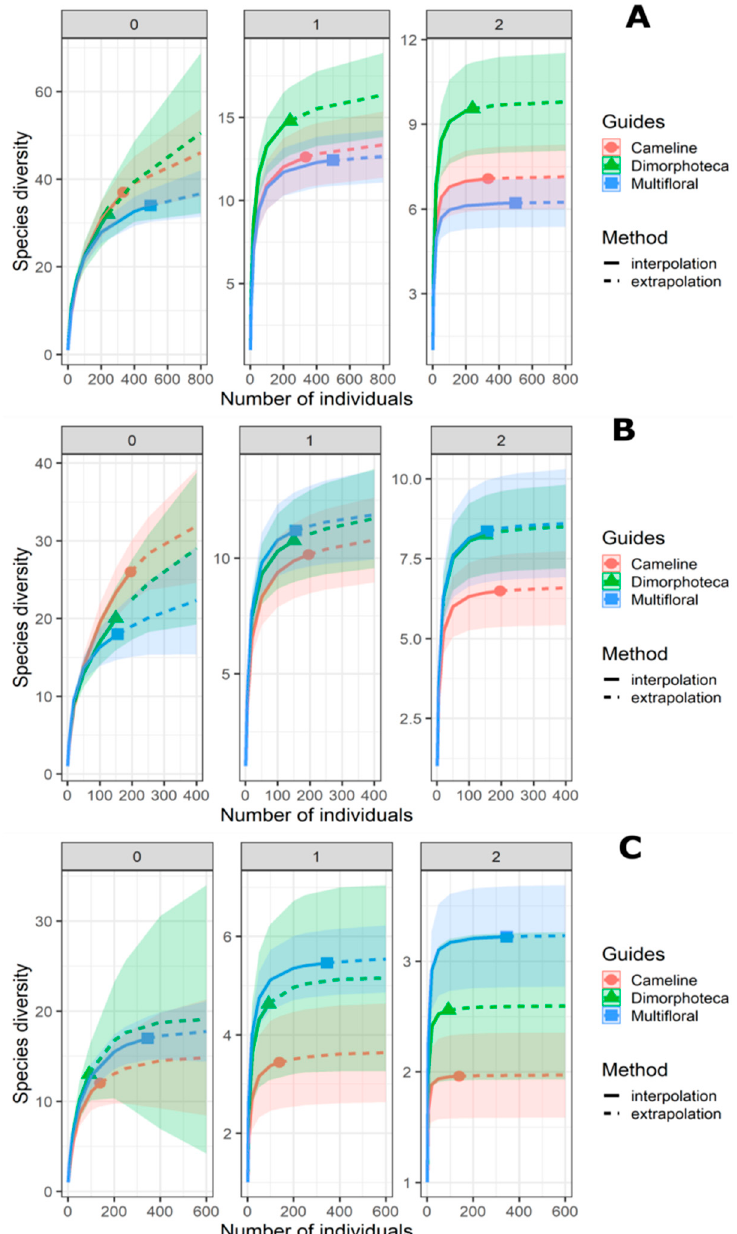
Figure 3. Comparison between pollinator communities from the three floral treatments (denoted by colours and solid dots) by sample-size-based rarefaction (solid lines) and extrapolation (dashed curves) curves based on abundance data of hoverflies and bees together ( A ), bees alone ( B ) and hoverflies alone ( C ). Each panel displays Hill numbers of order N = 0 (left panel), N = 1 (middle panel) and N = 2 (right panel). The 95% confidence intervals (coloured-shaded regions) were obtained by a bootstrap method based on 100